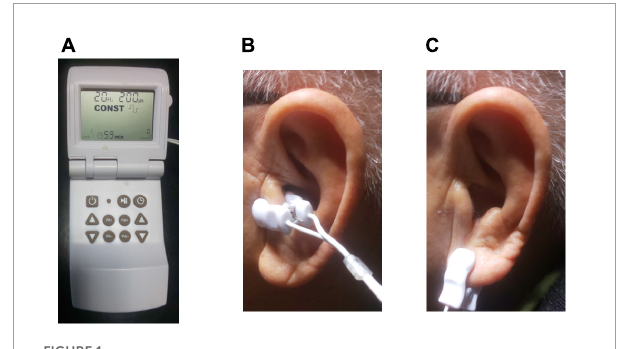
FIGURE1 Transcutaneous electrical vagus nerve stimulation. (A) The device used for stimulation (Parasym, London, UK). (B) For active stimulation, the ear clip was attached to the left tragus, which is innervated by the auricular branch of the vagus nerve. (C) For sham control stimulation, the ear clip was attached to the left ear lobe, which is devoid of vagal